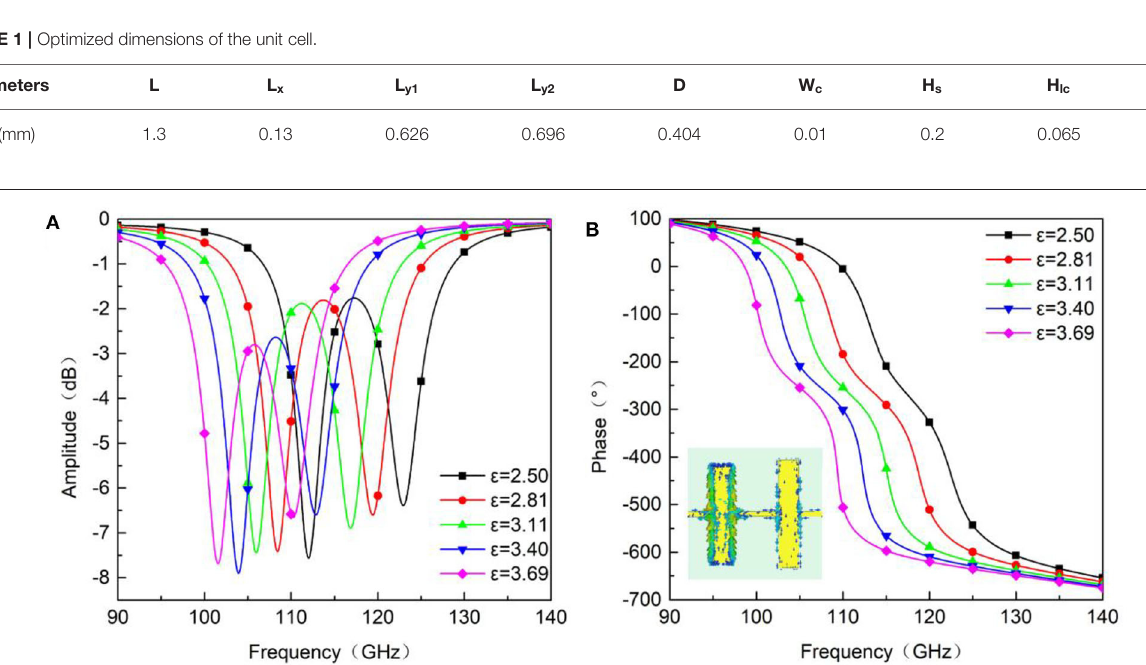
number decreased from 1,521 to 169, which represents an 88.9%